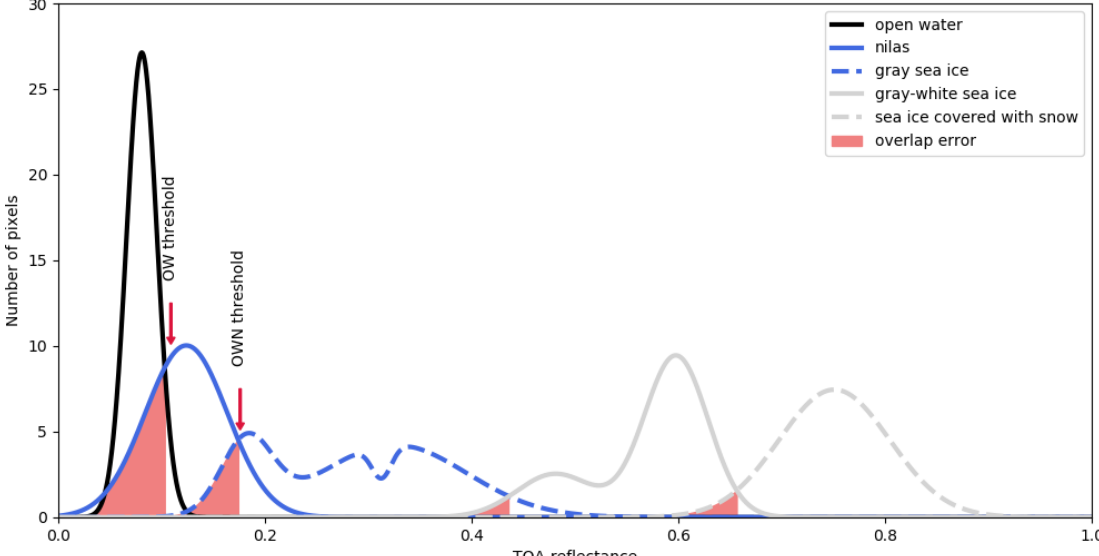
Figure 3. The number of pixels within every surface type for a specific TOA reflectance. The TOA reflectance threshold for each surface type is the point of intersection of two curves adjacent to each other. The error is shown as the overlap error of these two curves below each threshold. The red arrows show the two thresholds later used for the lead identification for the lead-width measurement: the open-water (OW) threshold and the open-water-and-nilas (OWN) threshold.